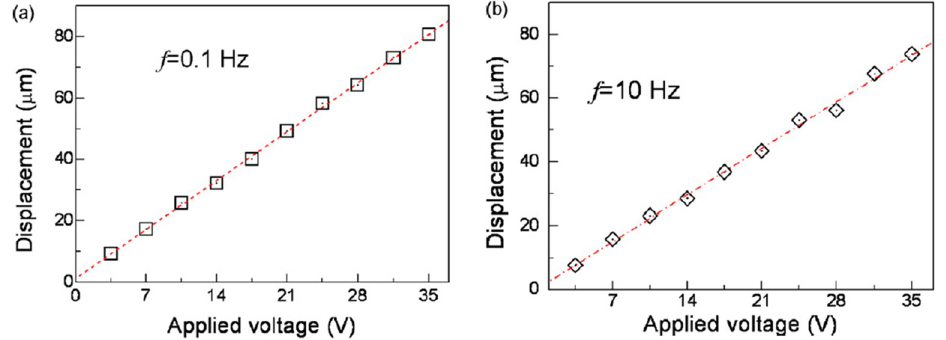
Figure 7. Plots of the bending displacement versus the applied voltage (Vamp) at the frequencies of ( a ) f = 0.1 Hz and ( b ) f = 10 Hz [47]. ( a ) f = 0.1 Hz and ( b ) f = 10 Hz